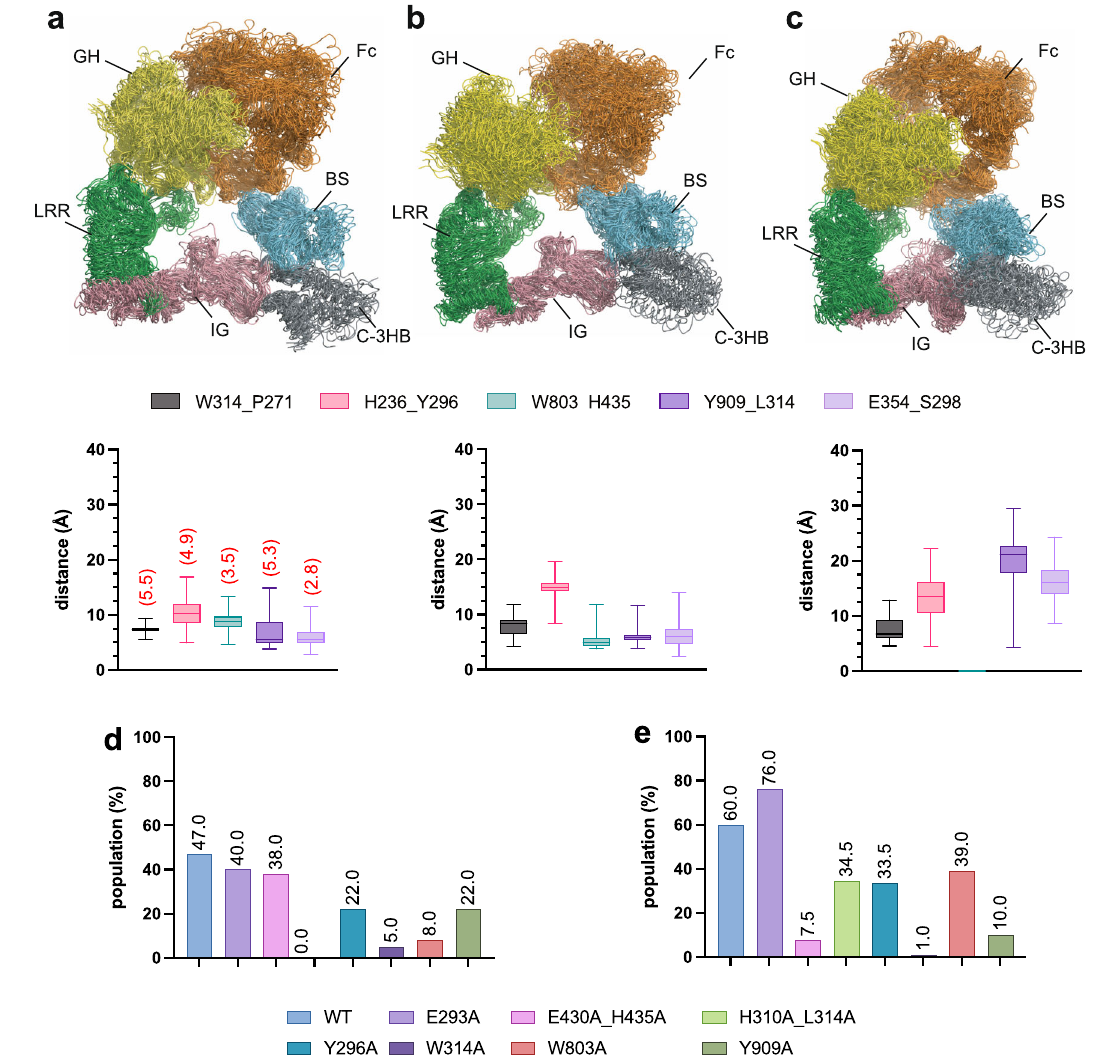
Fig. 4 | Molecular dynamics (MD) simulations studies. Overlay of 25 frames evenly spaced along the 1 µ s MD trajectory for ( a ) EndoS-Fc, ( b ) EndoS-Fc E293A ( c ) EndoS W803A-Fc , along with the average distance between representative residues. The EndoS protein is shown as blue ribbons and the antibody as gray and orange ribbons. Box-and-whisker plots, showing the minimum, maximum, median, 1st quartile, and 3rd quartile bars, as well as the interquartile range, based on n =250 evenly distributed values obtained from the MD trajectories. The numbers in red andinparenthesesaretheexperimentalvaluesfoundinthecryo-EMstructure.For aromaticresiduesandPro,thecenterofthearomaticringandthecenterofthering are considered, respectively, for these calculations. For L314, S298 and E354